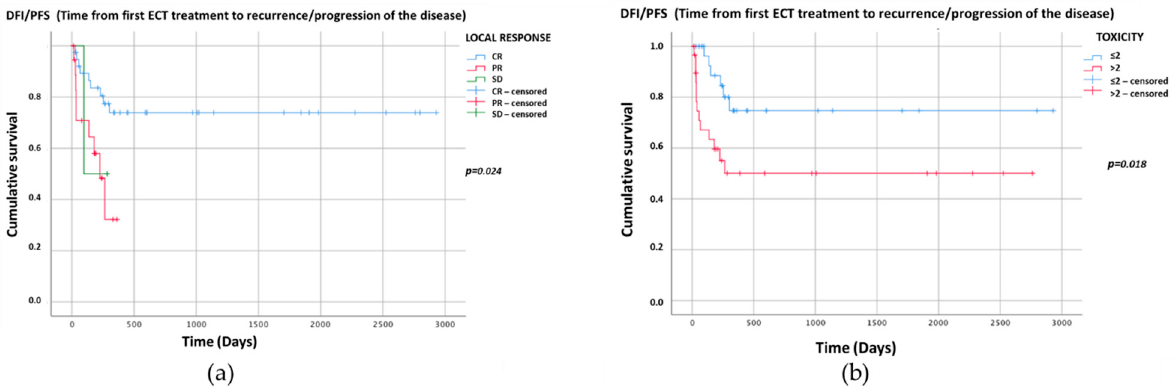
Figure 2. Kaplan–Meier graphs of the two categorical variables with p < 0.05 showing DFI/PFS (days). The comparison of survival curves with the log-rank test for ( a ) local treatment response p = 0.024 (CR: median NR, 95%CI NR; PR: median 225, 95%CI 139–311; SD: median 97, 95%CI NR); and ( b ) toxicity p = 0.018 ( ≤ 2: median NR, 95%CI NR, >2: median NR, 95%CI NR). NR—Not reached. Table 3. Univariate and multivariate analyses for the relationship between variables and tumor-specific